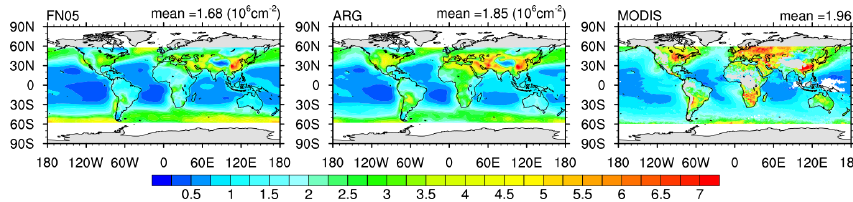
Figure 5. Annual vertically integrated droplet number concentration (10 6 cm − 2 ) from GEOS-5 using the Fountoukis and Nenes (2005) (FN05) and Abdul-Razzak and Ghan (2000) (ARG) CCN activation parameterization, and from the MODIS retrieval, calculated using Eq. (38). Data for latitudes higher than 60 ◦ have been excluded from the